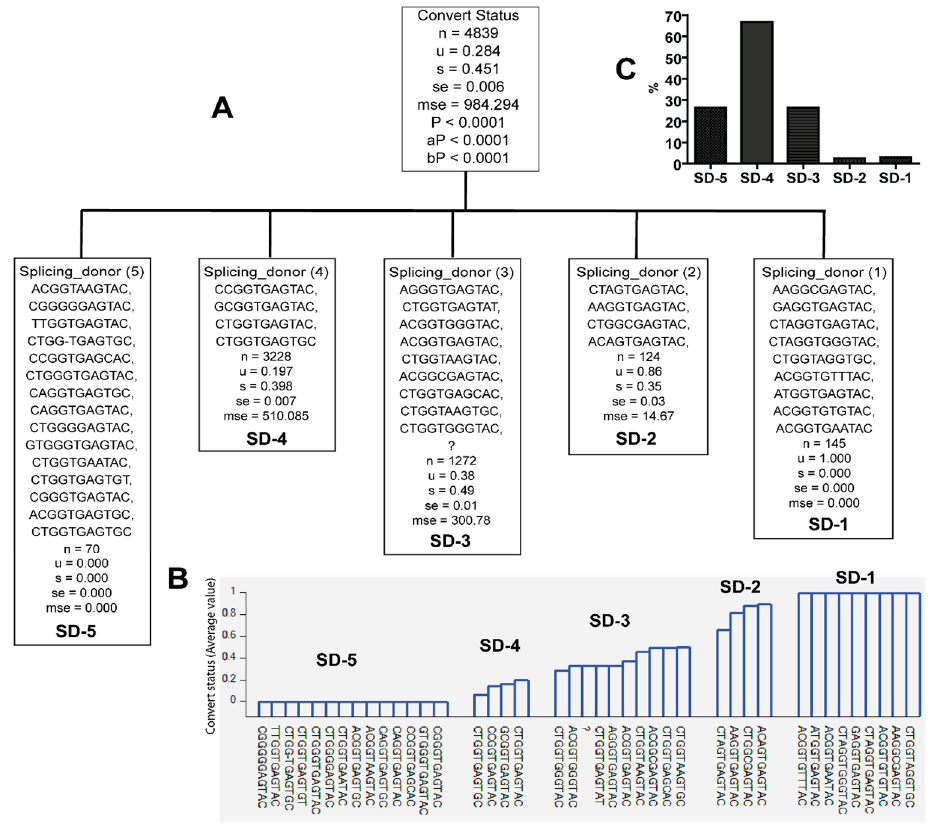
Figure 4. Classification of splicing donor (SD) sequence variants according to whether they were identified from late seroconverters ( u = 1) or early seroconverters ( u = 0). Note: question mark denotes lack of sequence. u— mean value; s—standard deviation; se—standard error; mse—mean square error; p — p value; aP—adjusted p value; bP—Bonferroni corrected p value. ( A ) Classification tree; ( B )